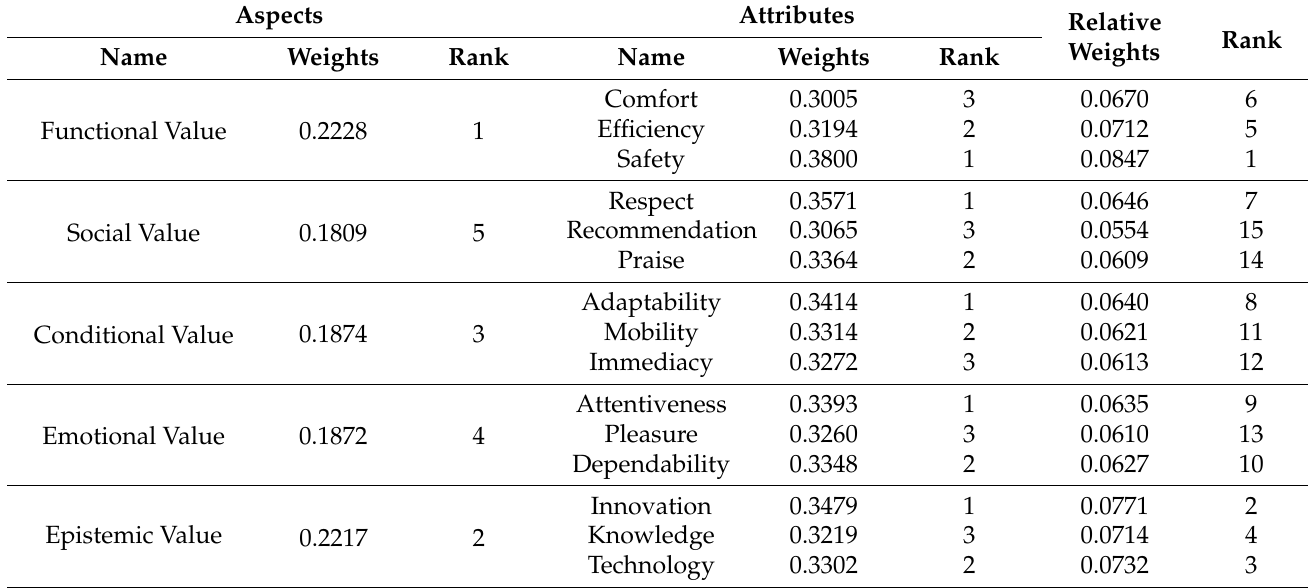
Table 9. Aviation companies service quality weights.